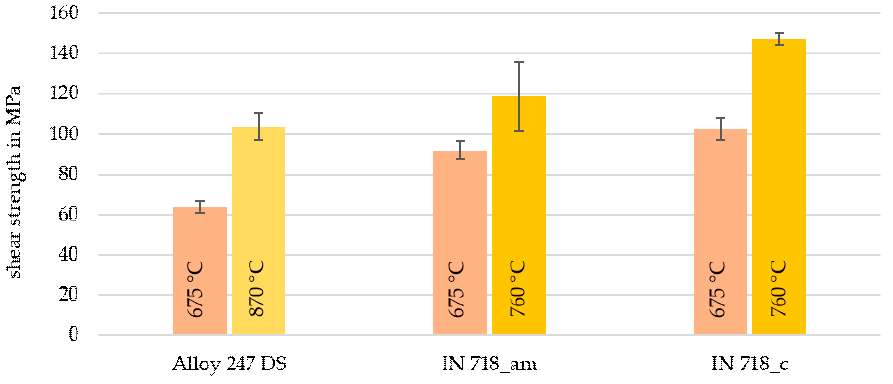
Figure 5. Shear strengths as a function of joining temperature (holding time: 15 min, joining pressure: 23.3 MPa) by using paste Ni90_T_KD4; the bar indications correspond to ± standard error.